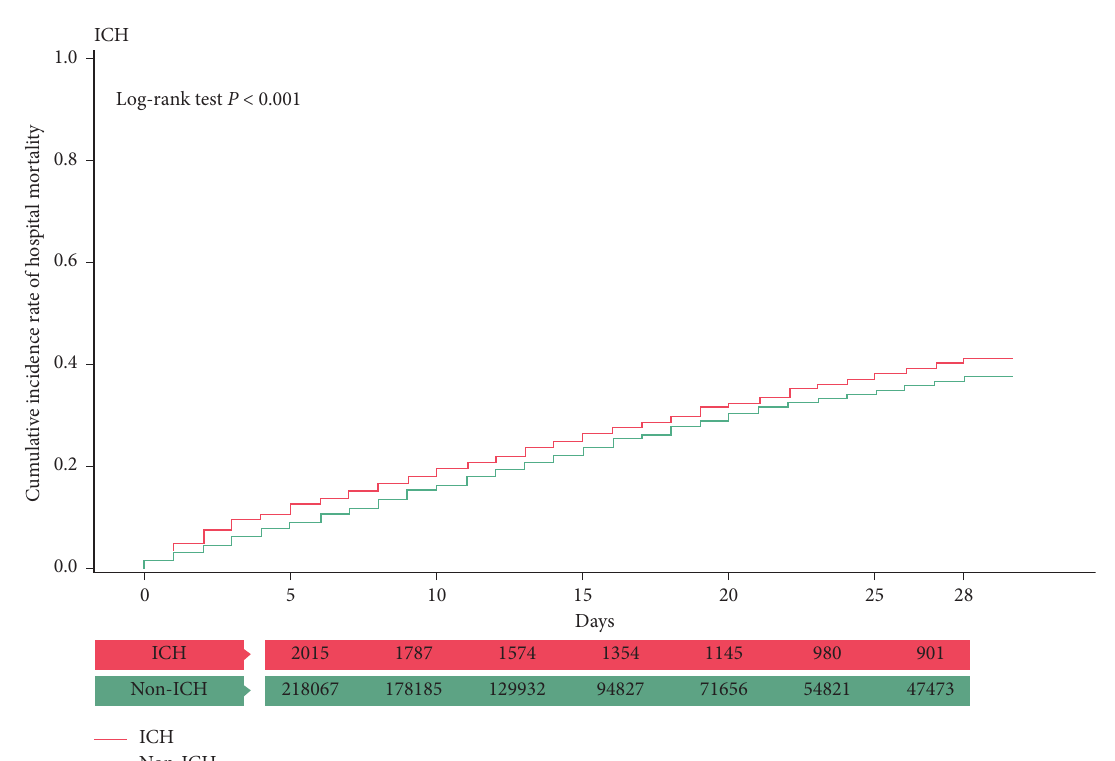
Figure 2: Kaplan–Meier analysis of cumulative hospital mortality in sepsis patients with and without ICH. The differences were evaluated by the log-rank